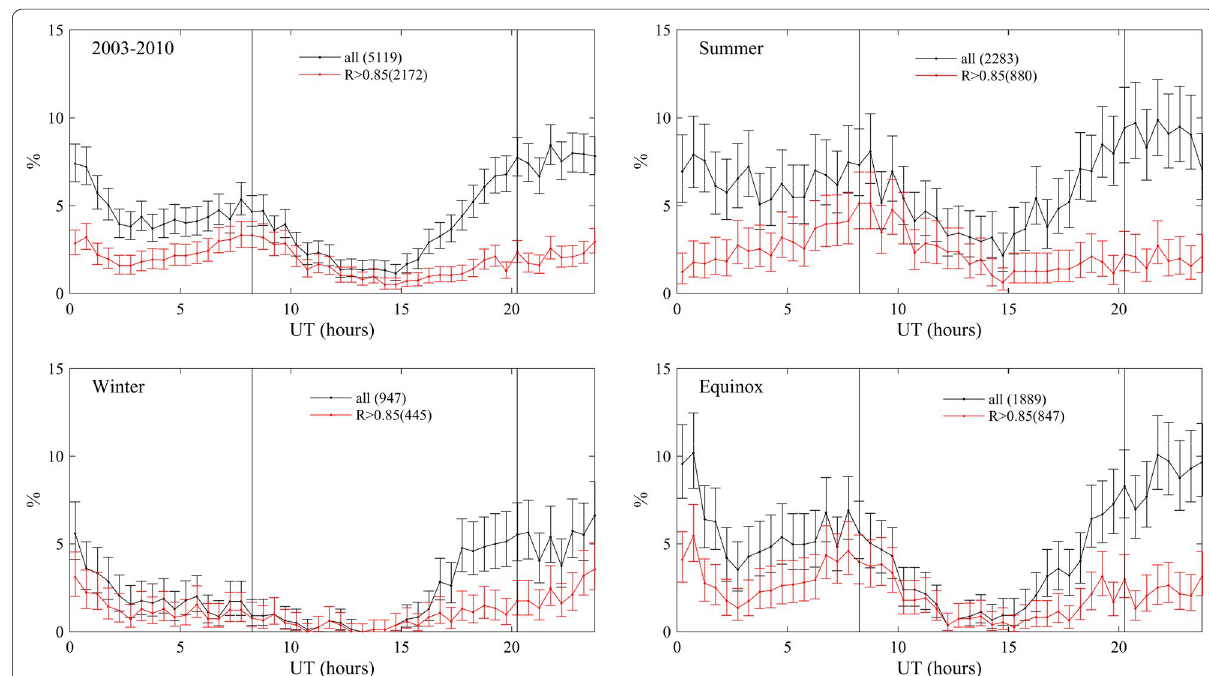
Fig. 6 Daily variation in ULF events. The UT distribution of events, normalized to the available data for each time interval, for the entire time interval, 2003–2010, and separately for summer, equinoctial, and winter months. For each time interval, the number of total events is indicated in parenthe- ses. The vertical lines at approximately 08 UT and 20 UT indicate the magnetic midnight and noon,